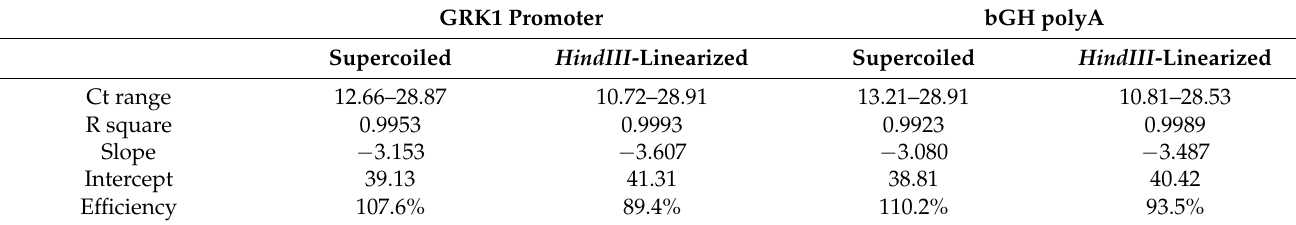
Table 2. PCR efficiency and performance on undigested and digested plasmid